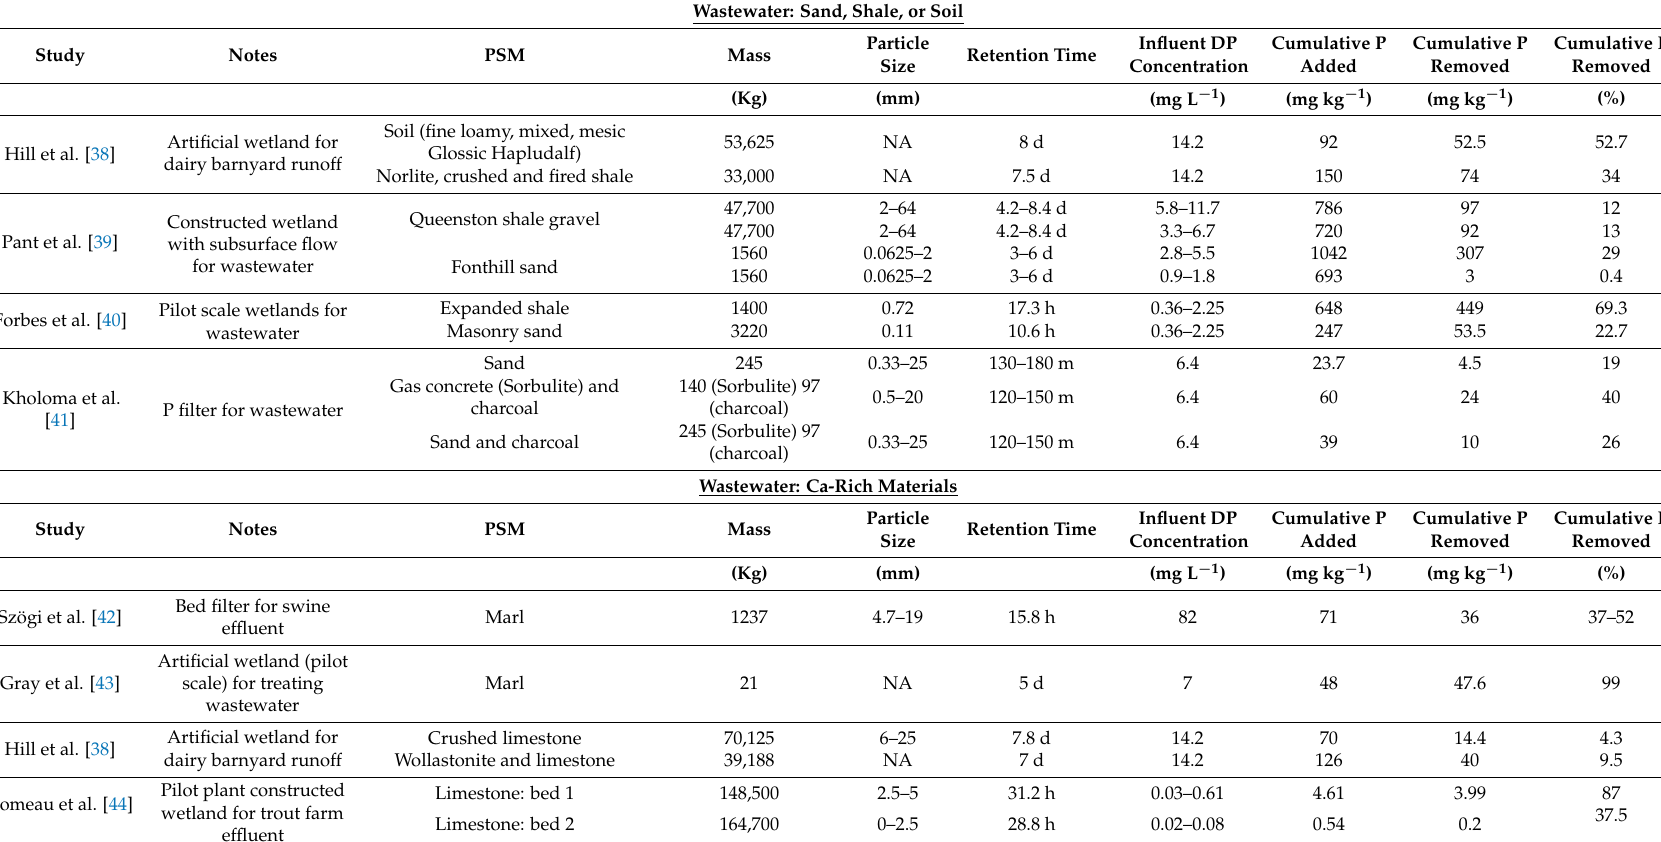
Table 1. Summary of design, conditions, and phosphorus (P) removal performance for various wastewater and non-point drainage P removal structures. Data are primarily organized based on inflow water type (wastewater vs. non-point drainage), secondary by type of P sorption material (PSM), and tertiary by chronology. DP: dissolved